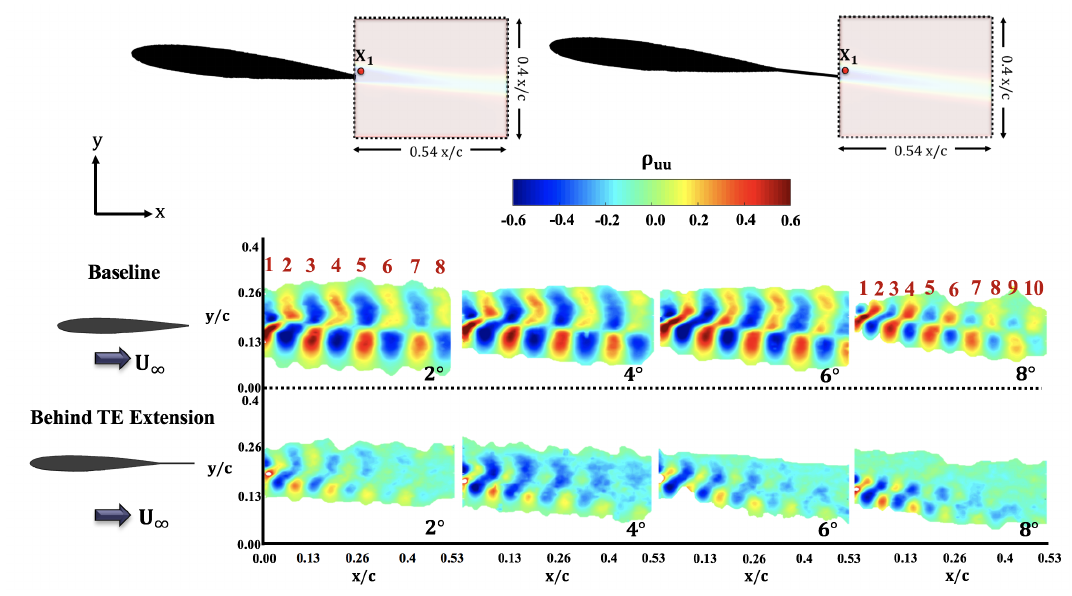
Figure 16. Contours of two-point correlations of the streamwise velocity component for the baseline wing and for the wing with TE extensions. Weaker correlations are observed in the wake behind the TE extension, indicating lower length scales and velocity fluctuations.